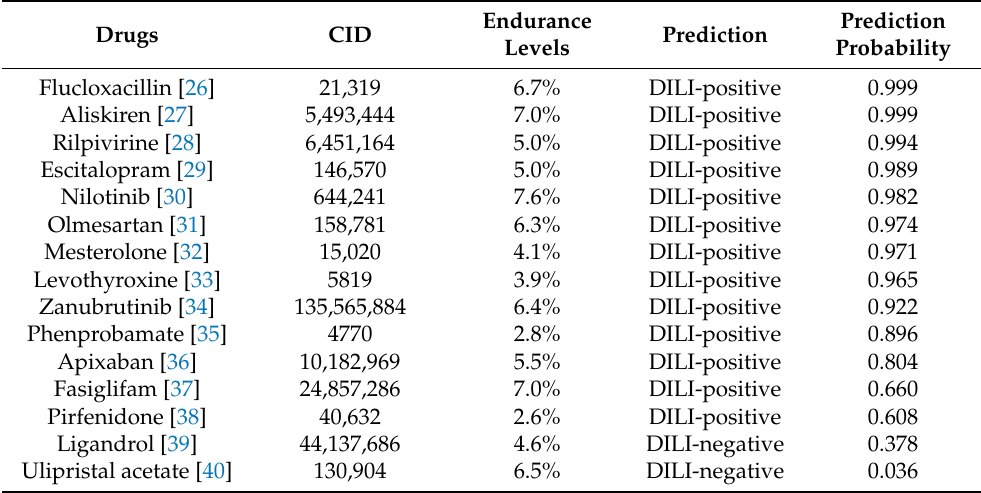
Table 6. Evaluation results of the DNN model using 15 drugs with case